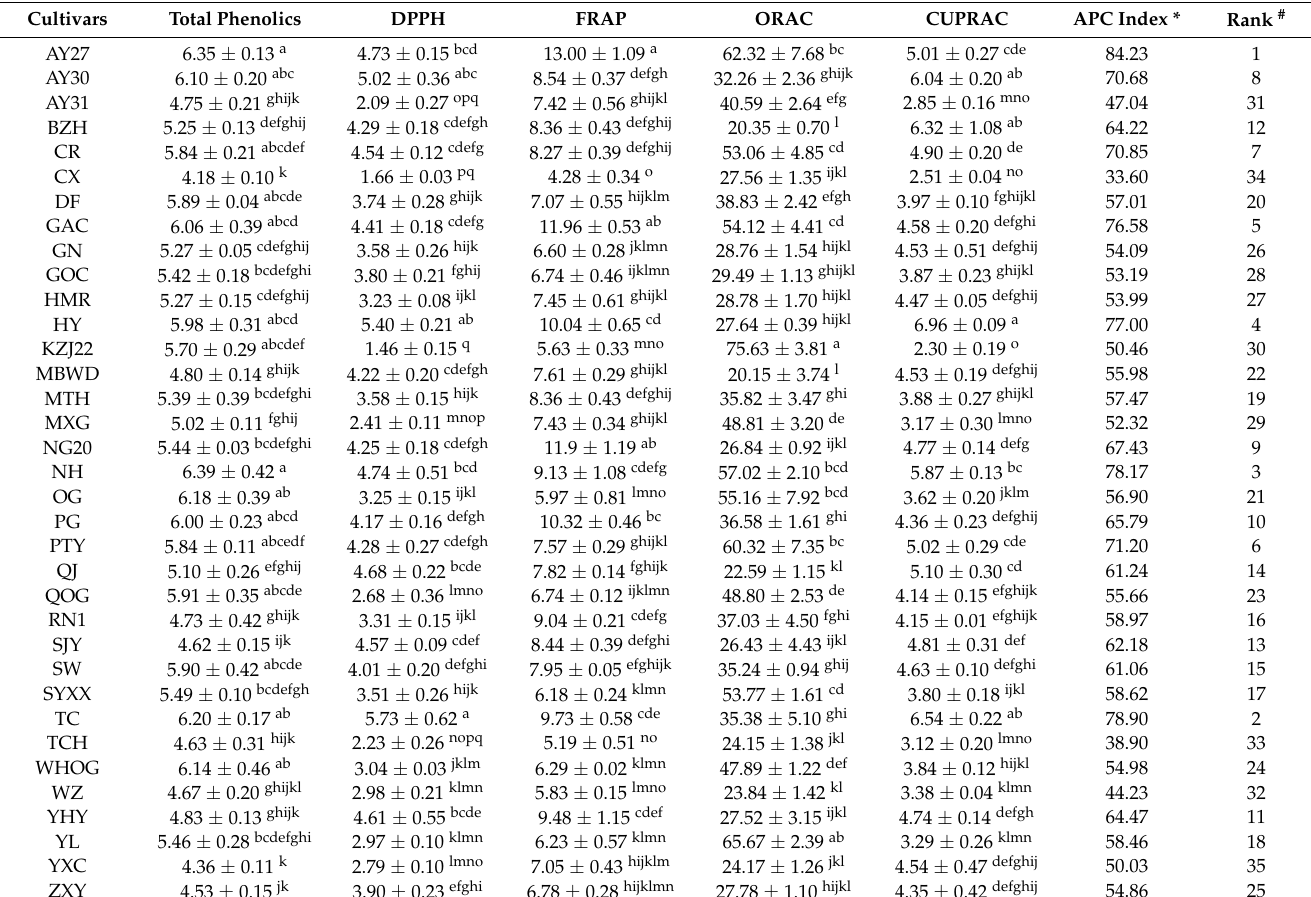
Table 5. Total phenolics and antioxidant properties of citrus fruit juice sacs of 35